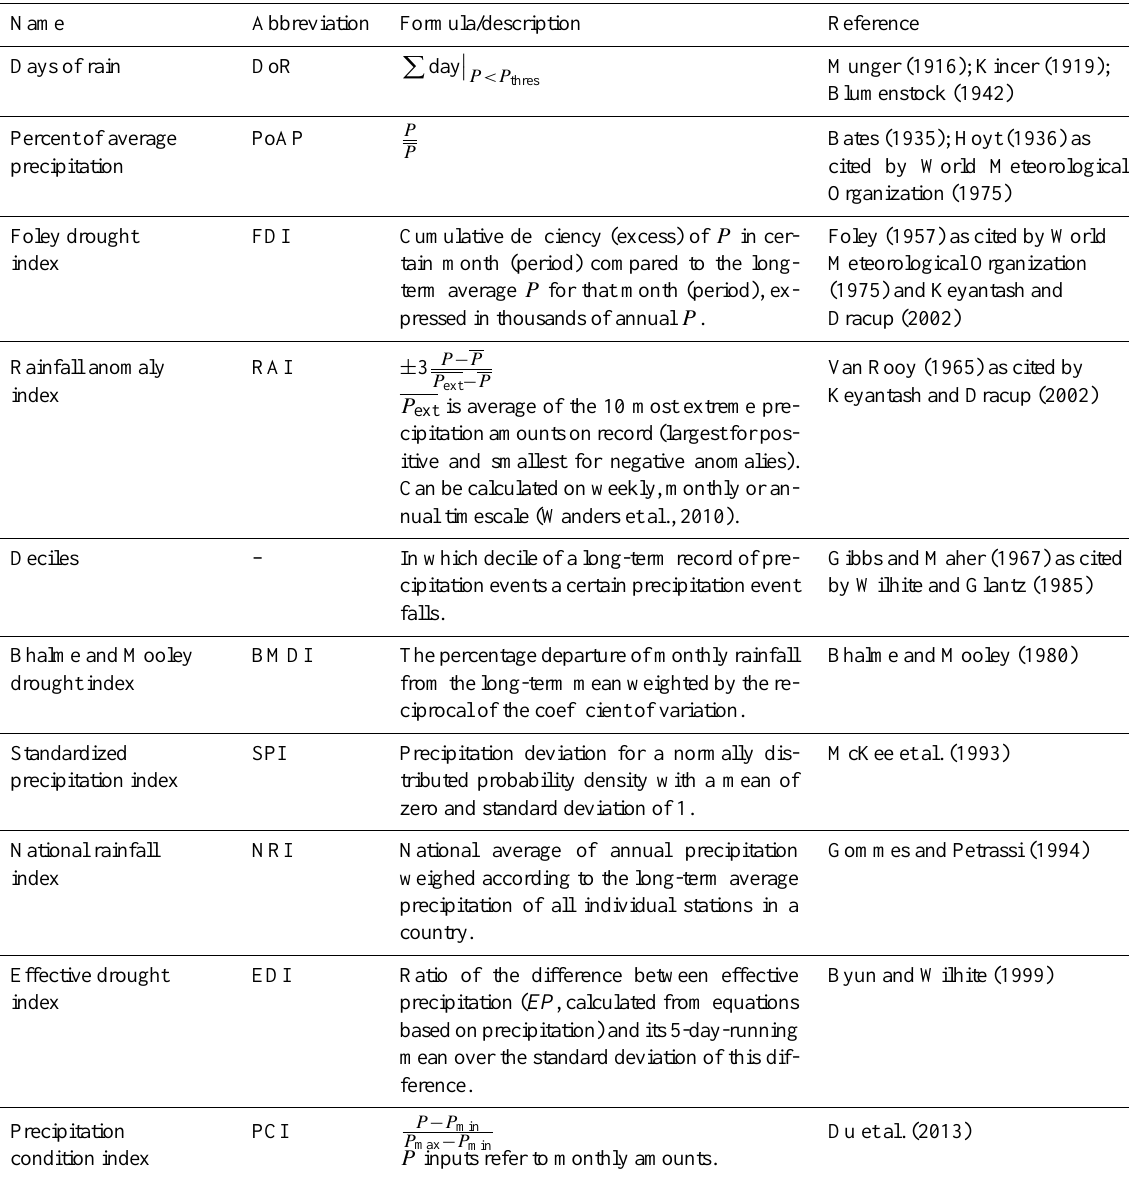
Table B1. Meteorological drought indicators based on precipitation